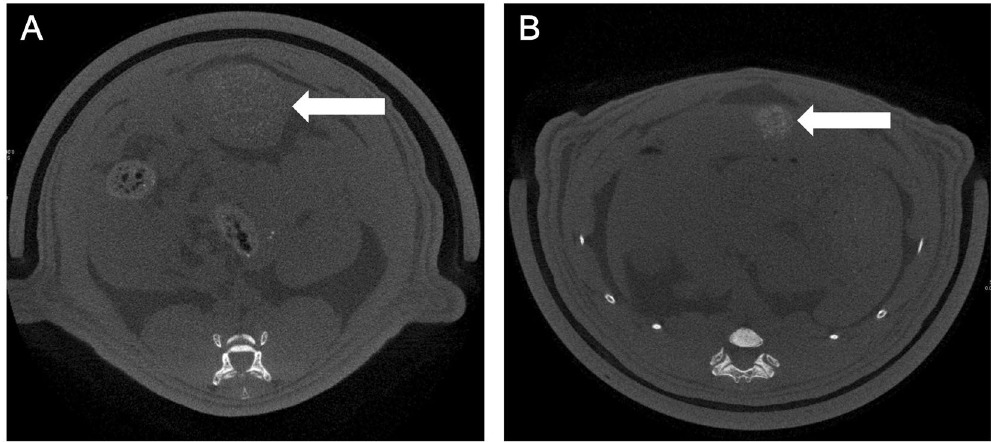
Figure 9. Hyper-attenuated spots appeared in the index tumor after IA administration of SOF/TIBA/PLGA20 MSs on CT images obtained on day 1 ( A ) and day 7 ( B